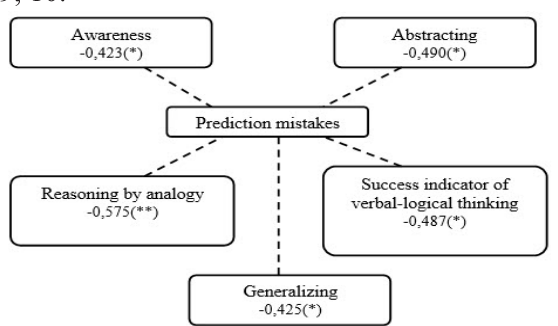
Figure 7. Correlation of prediction mis- in children of preschool age